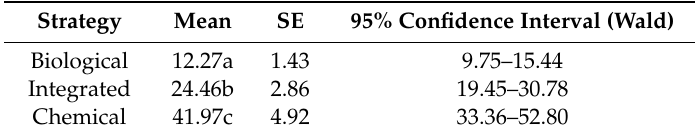
Table 4. IDA (insect-day accumulated) values for B. tabaci at the end of the zucchini cultivation (week 7) under three different whitefly control strategies. Means within a column followed by the same letter are not significantly different a p = 0.05; Wald Chi-Squared Test = 43.21, gl = 2, p < 0.0001.